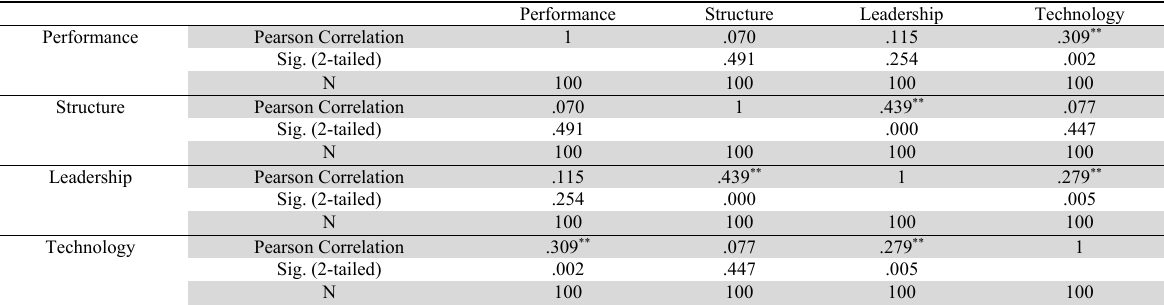
The results of correlations